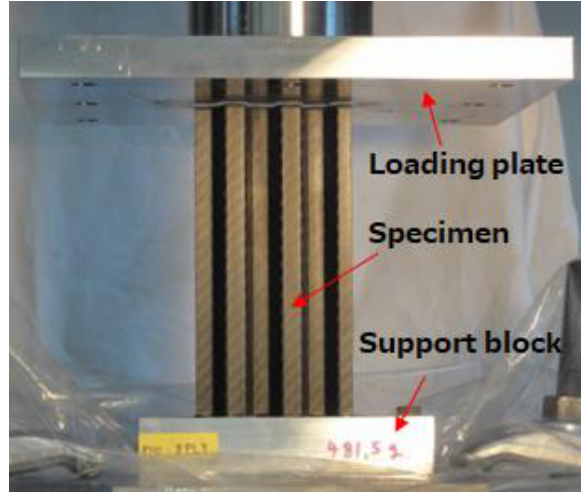
Figure 9. Experimental setup for quasistatic compression test.